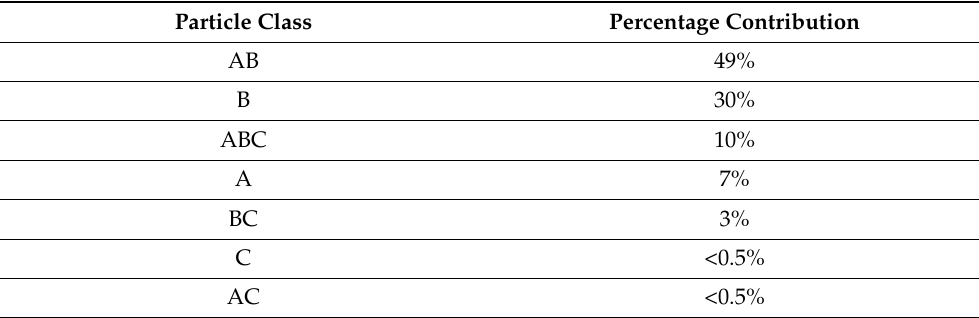
Table 2. WIBS particle distribution (% of total fluorescent particles) using Perring